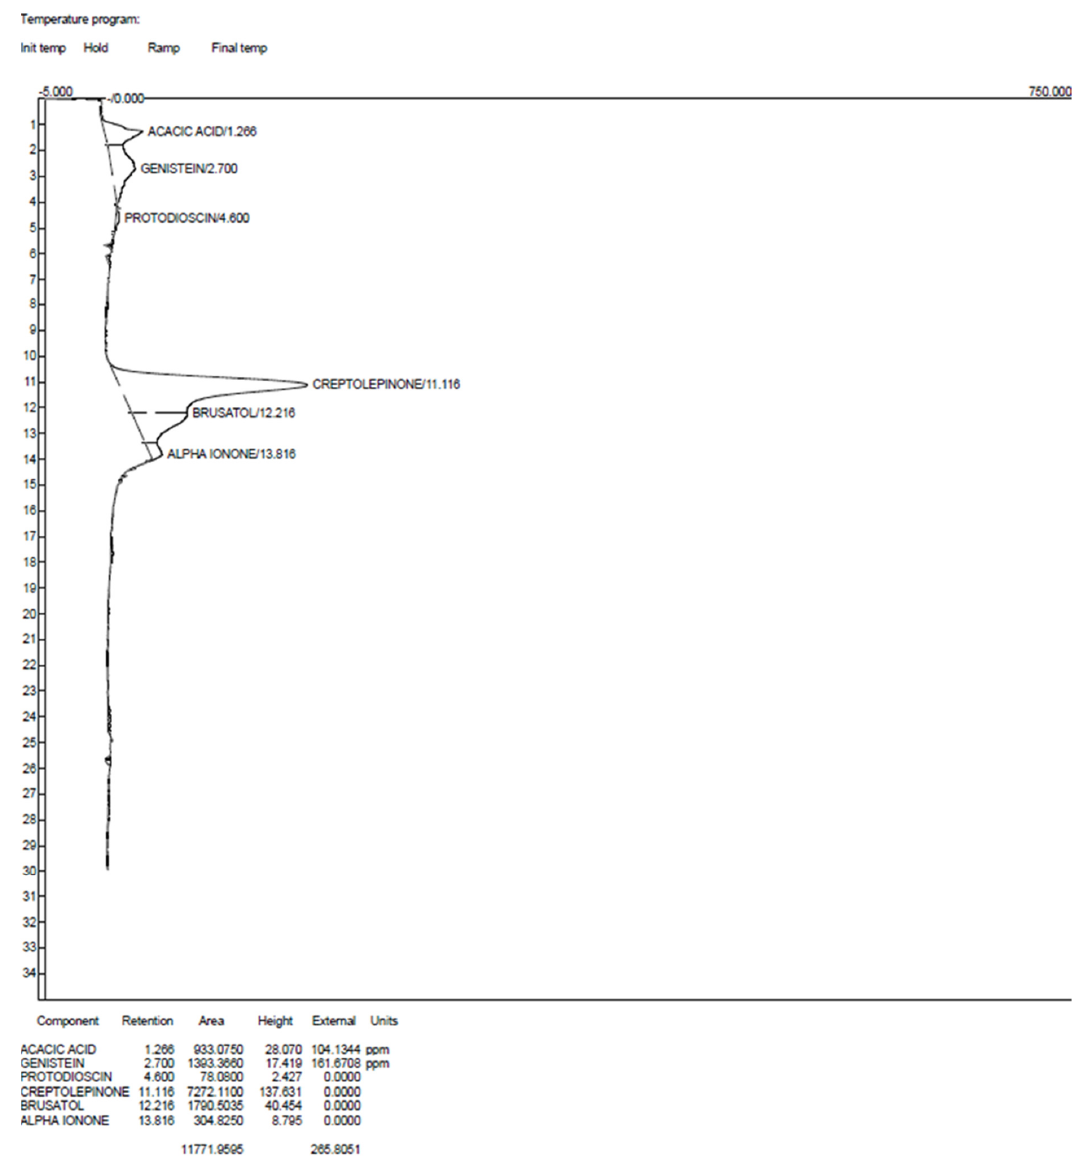
Figure 9. Chromatogram of hexane extract of C. papaya